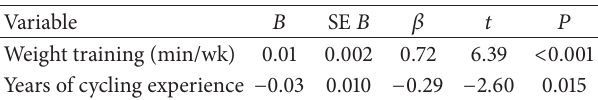
Table 4: Linear regression analysis summary for cyclist characteris- tics and femoral neck BMD ( 𝑁 = 30